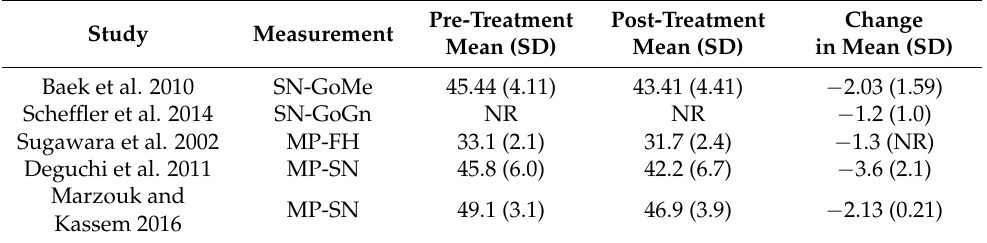
Table 12. The results of measurements indicating mandibular autorotation as a result of anterior open bite treatment by molar intrusion using skeletal anchorage (degrees).